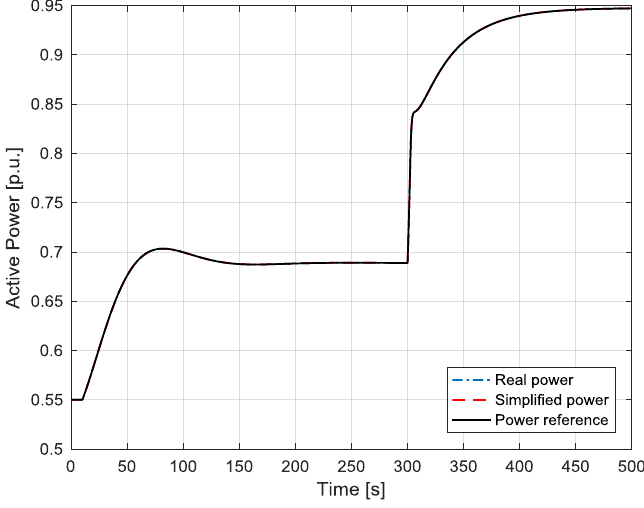
Figure 19. Active power time profile.